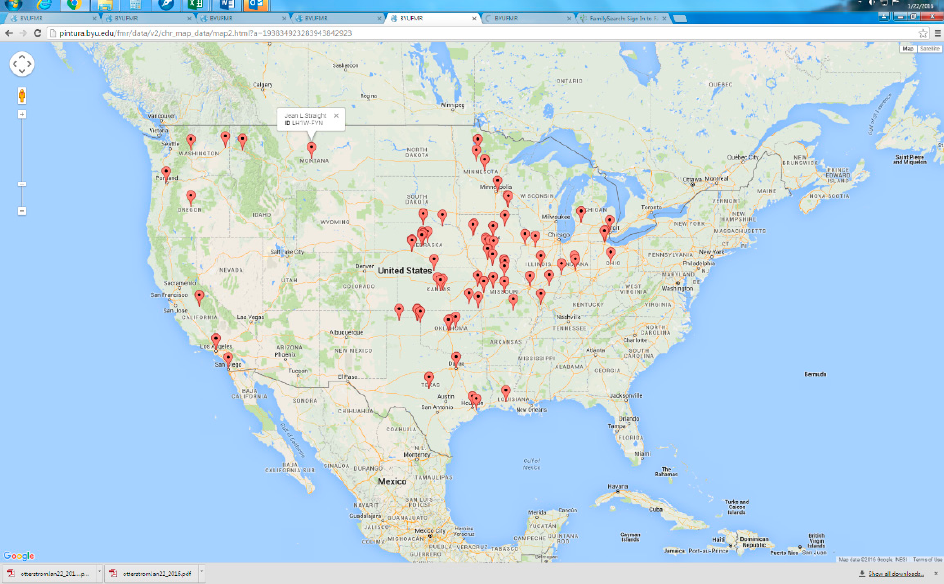
Figure 4. Birth locations of grandchildren of individuals born in Indianapolis in 1850. The varying MMDs by generation pair and among the ten sample cities show that time and place affected the movement of families (Table 1). For example, the MMDs from the second to third generations were small in Chicago, but quite large in Indianapolis. This makes one wonder what made the cities descendants move so differently across time and space.